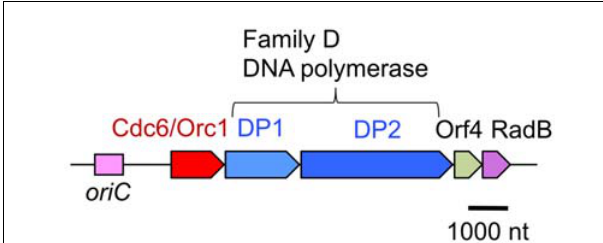
FIGURE 3 | Physical map of the P. furiosus chromosomal segment bearing the replication origin and the replication proteins. The genes encoding PolD, the archaea-specific DNA polymerase, is located near the replication origin, oriC , and are transcribed as an operon with the initiator protein, Cdc6/Orc1, and a recombination protein, RadB.